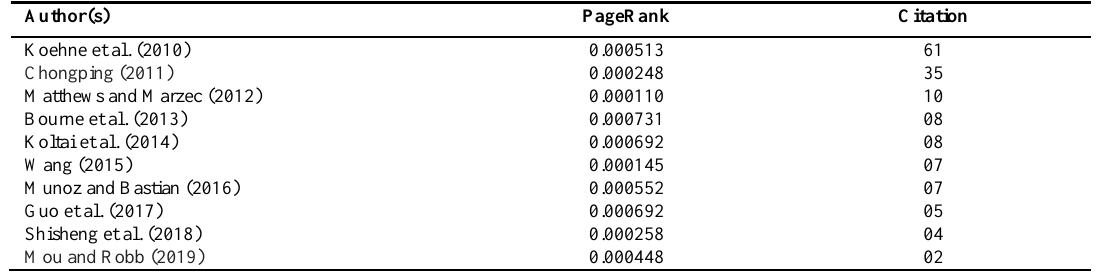
Table 11. Top 10 articles based on PageRank analysis: intellectual capital and operational